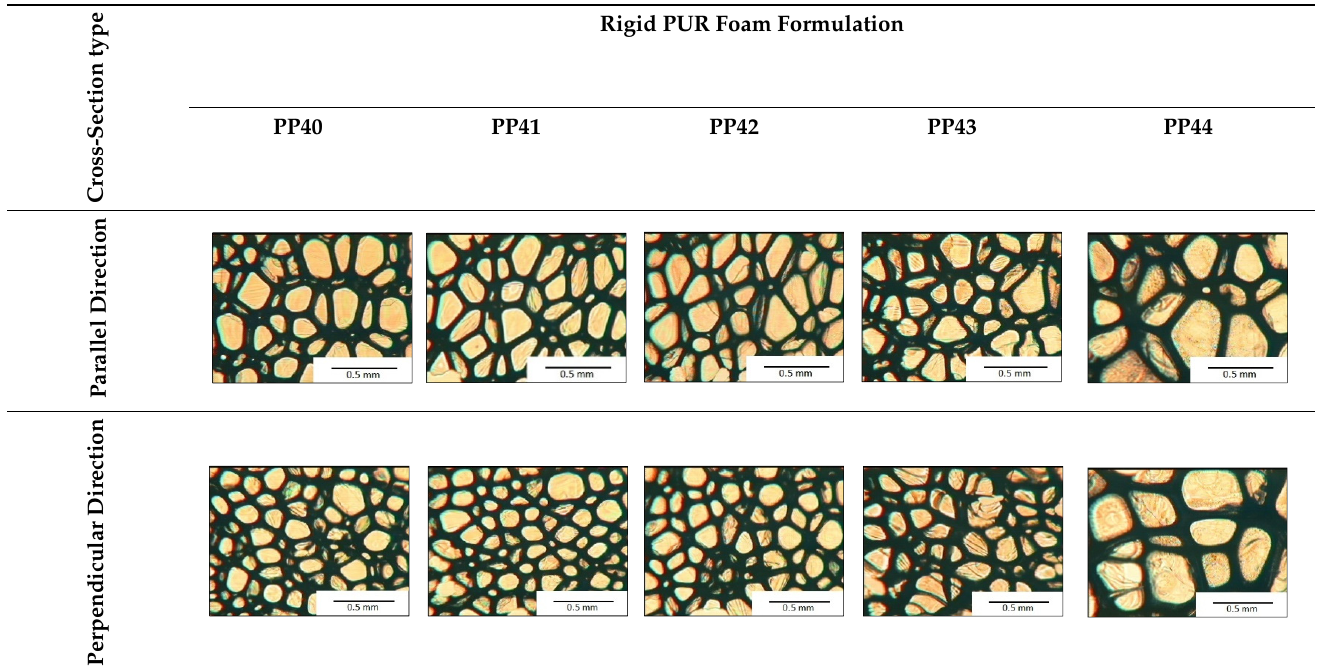
Table 5. Optical microscope images of rigid polyurethane foams PP40-44.